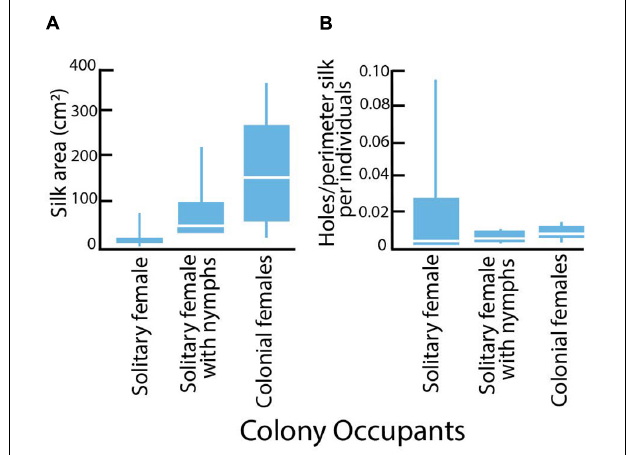
FIGURE 3 | Dispersal choices by adult female Antipaluria urichi in the laboratory. Paper cylinders represent trees of three sizes: 7, 11, and 15 cm diameter and 1 m tall. Each tree model was 1 m away from a central stick placed where the disperser would climb to survey the scene. Relative positions are not to scale in the drawing. Numbers represent the number of females choosing each cylinder in the choice test. Trial 1 results shown in red letters (Goodness of Fit Test X 2 = 30; DF = 2; P < 0.0001; Trial 2 in blue letters: Goodness of Fit Test X 2 = 24.4; DF = 2; P < 0.0001) and Trial 3 in